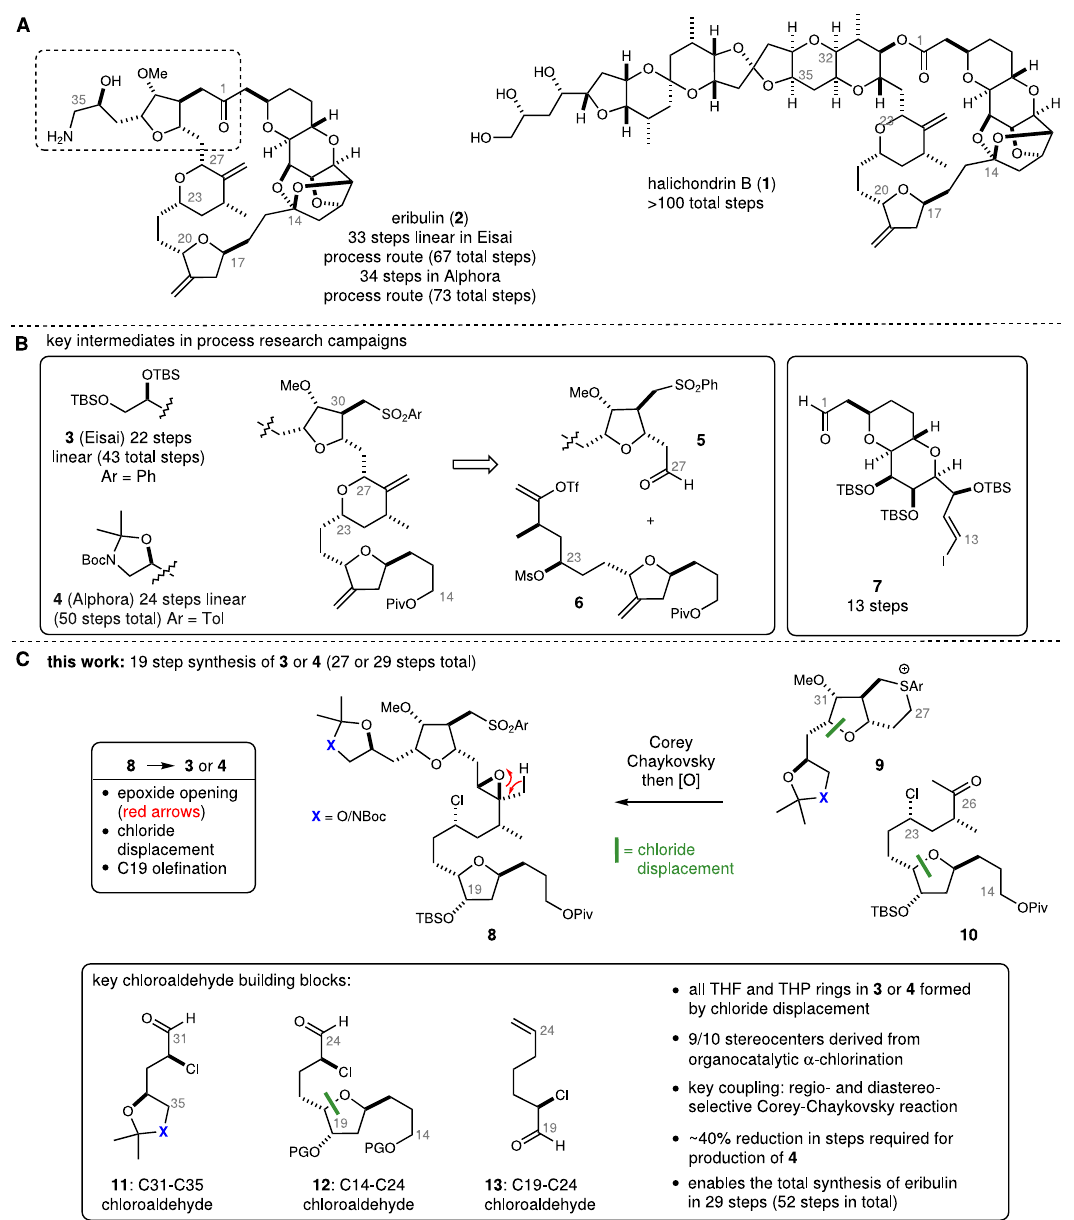
Fig.1| Eribulin:origins,EisaiandAlphoraprocesssynthesisintermediatesand α -chloroaldehyde building blocks for eribulin. A The anticancer marine natural producthalichondrinBandsyntheticanalogeribulin. B Keybuildingblocksusedin the Eisai and Alphora process synthesis of eribulin. C Key disconnections in our proposed eribulin synthesis rely on α -chloroaldehydes generated via